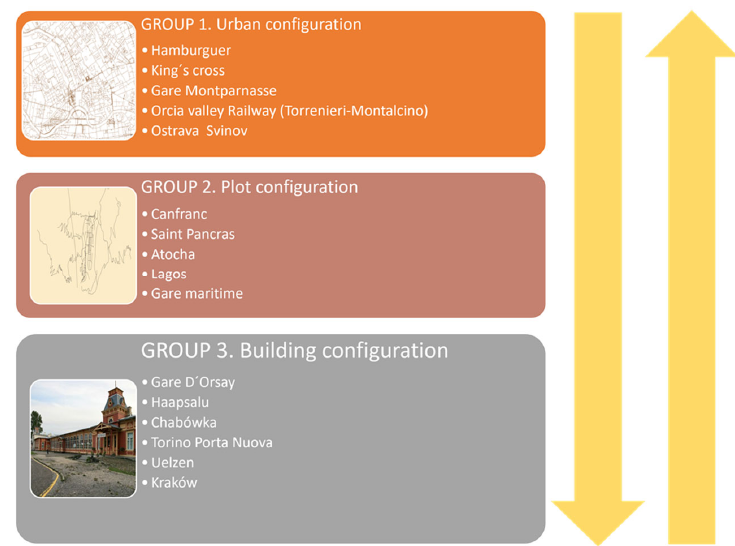
Figure 5. Classification by groups of analysis. Own elaboration.